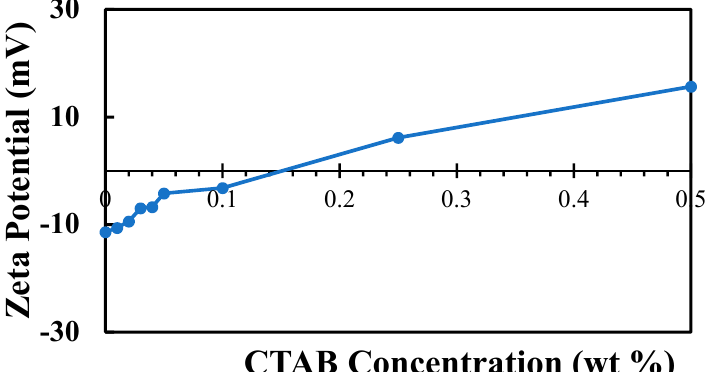
Figure 6. Variation of zeta potential and 1 wt% nanoclay dispersions as a function of CTAB concentration.